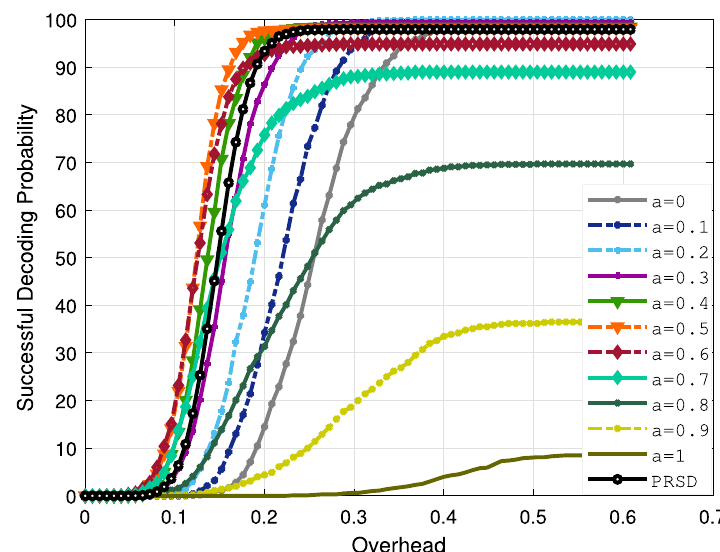
Fig. 7 Successful decoding probability with CPRSD for k = 250 and different